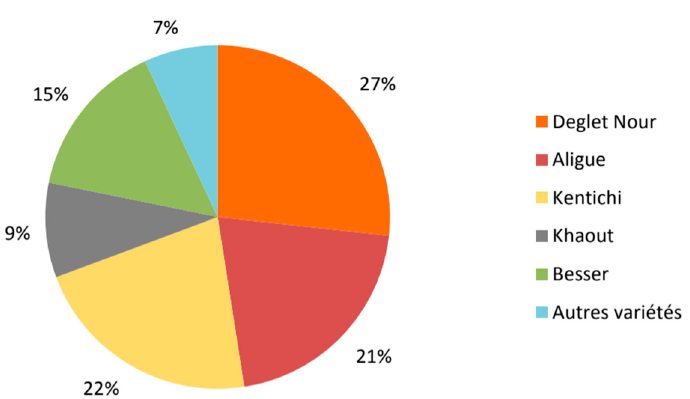
Figure 4. The main date palm cultivars in El Hamma oasis and their participation (%) in the whole production.